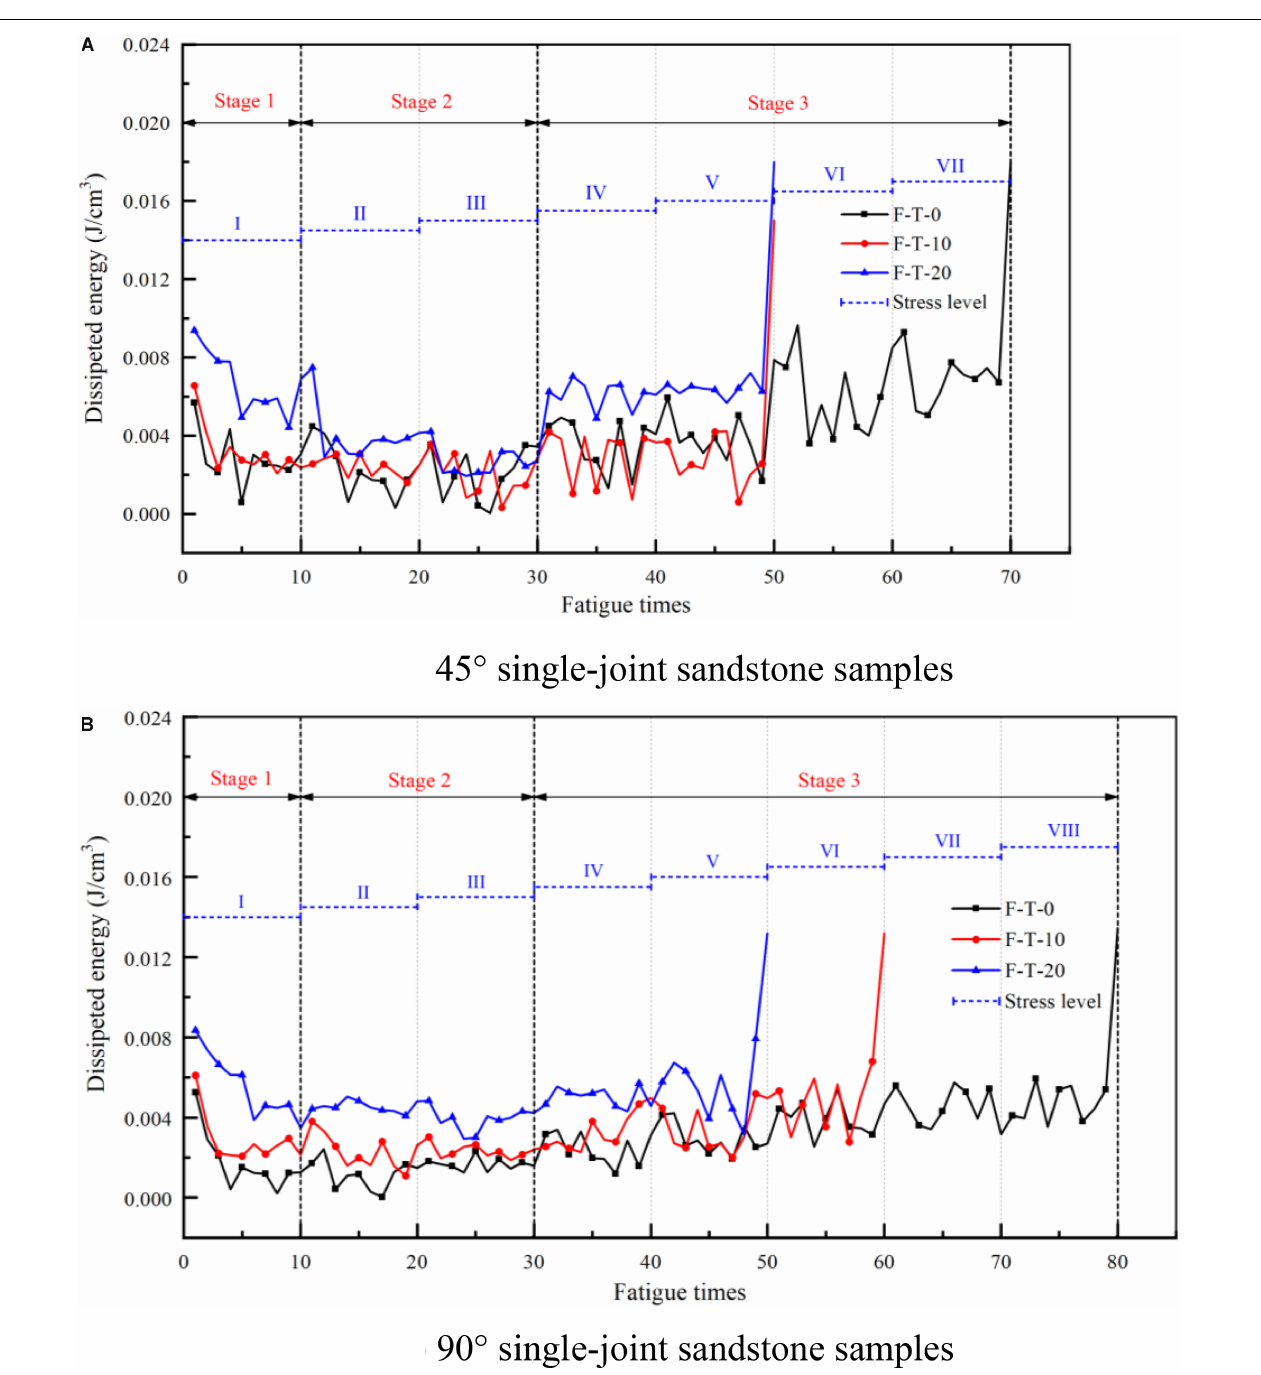
FIGURE 9 | Evolution law of dissipated energy per unit volume with fatigue times under different F-T cycles.